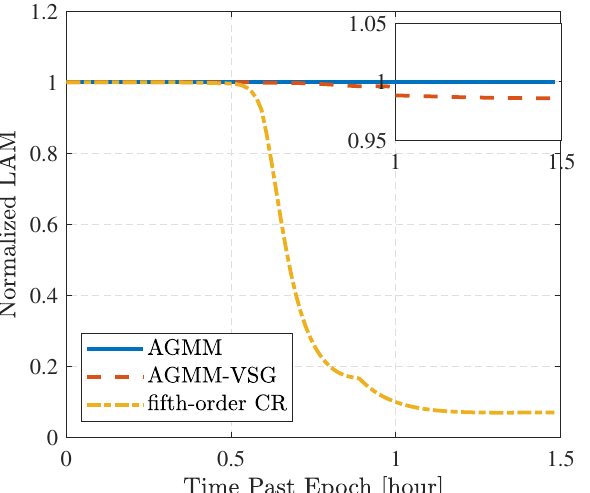
Figure 8. Likelihood agreement measure for the AGMM, AGMM-VSG, and fifth-order CR of LEO case.